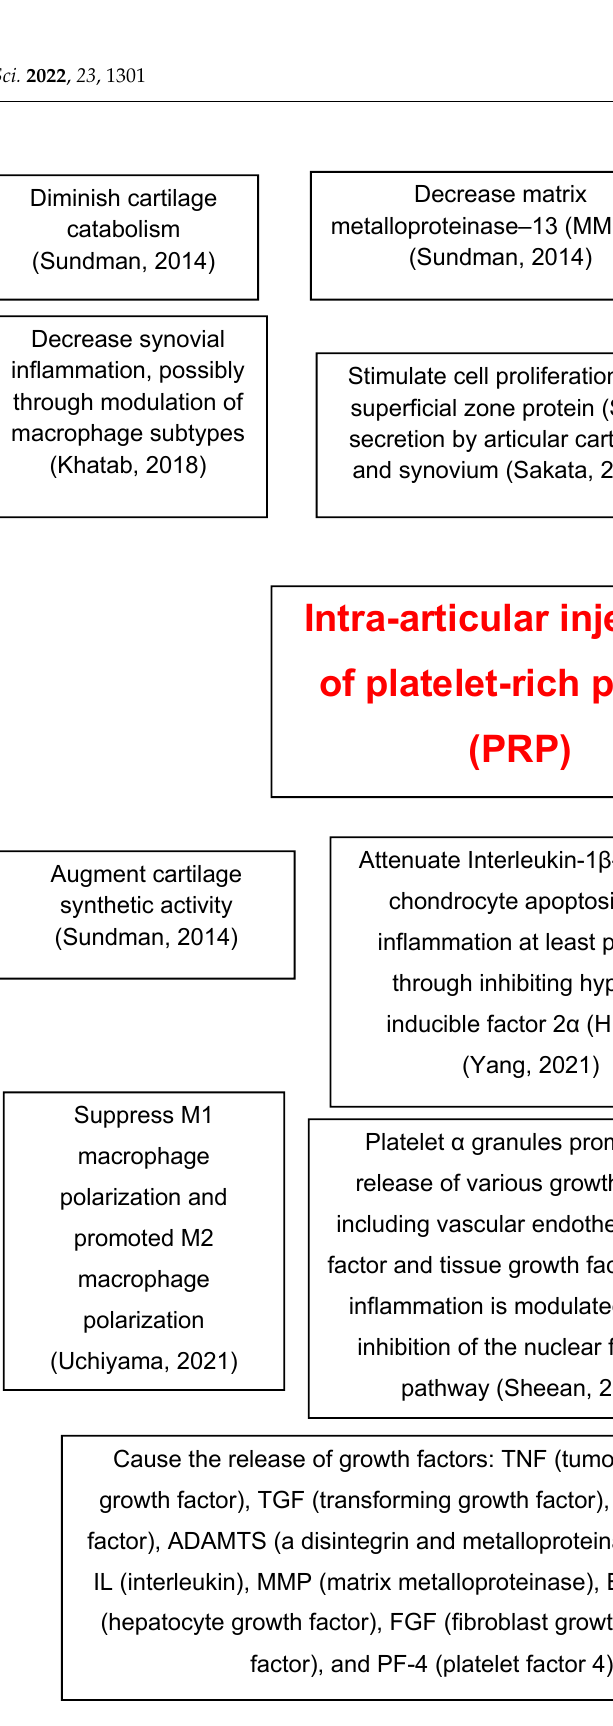
Figure 1. A summary of the molecular mechanisms of action of intra-articular injections of platelet-rich plasma (PRP) in knee osteoarthritis (OA) [4,27–30,32–36]